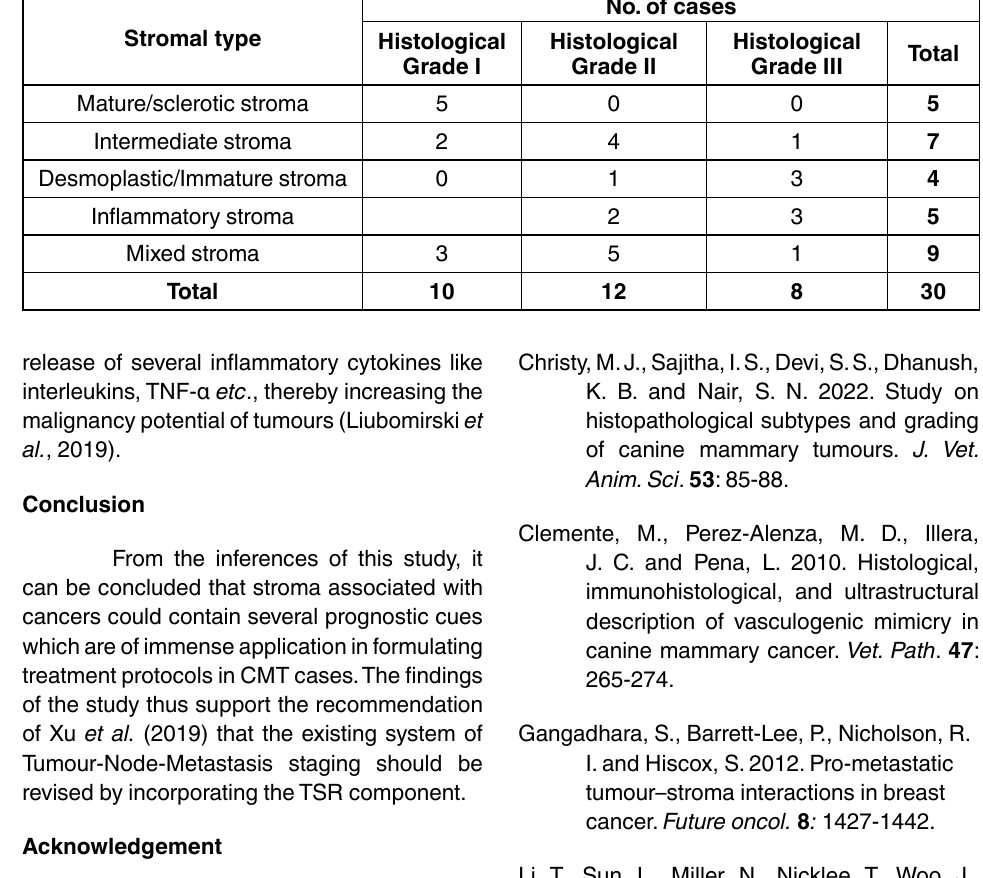
table 2 . Stromal types with respect to histological grades of tumour stromal type Mature/sclerotic stroma Intermediate stroma Desmoplastic/Immature stroma Inflammatory stroma